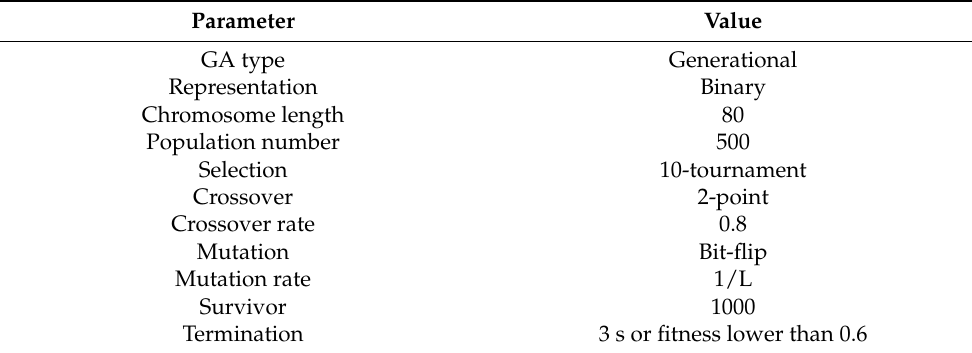
Table 3. Parameters used in the proposed hybrid genetic algorithm. GA, genetic